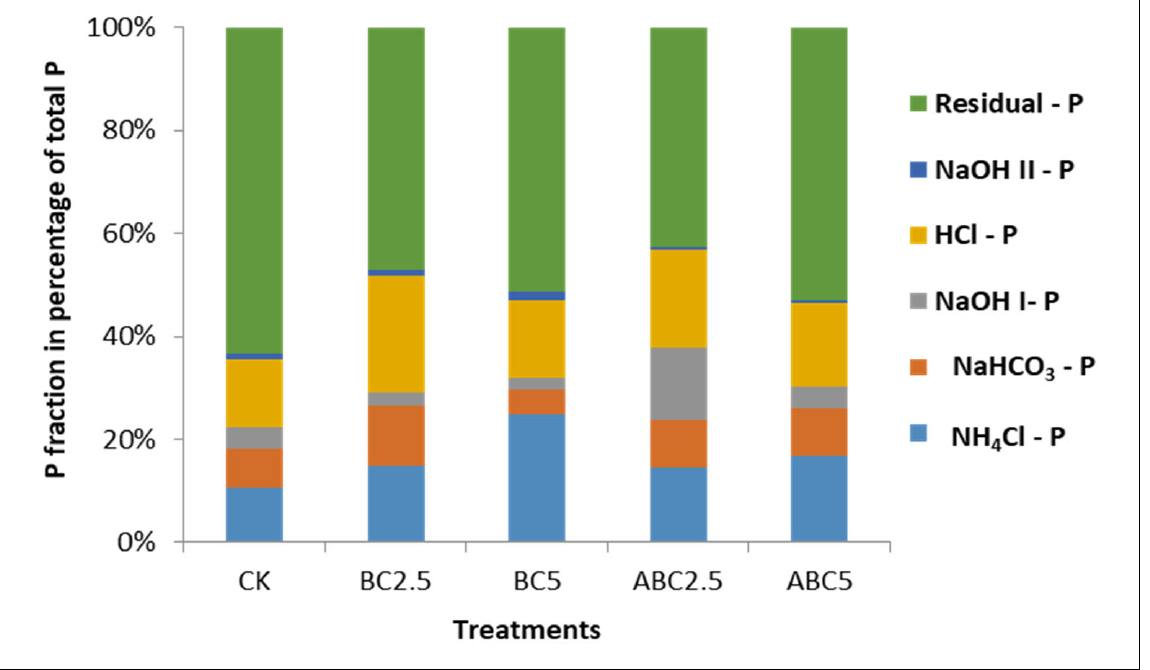
Figure 15. Effect of BC and ABC applied at different rates on P fractionation on soil treated with 75 ppm P. CK = Control, BC2.5 = Biochar added at 2.5% w / w , BC5 = Biochar added at 5% w / w , ABC2.5 = Acidified biochar added at 2.5% w / w , and ABC5 = Acidified biochar added at 5% w / w .